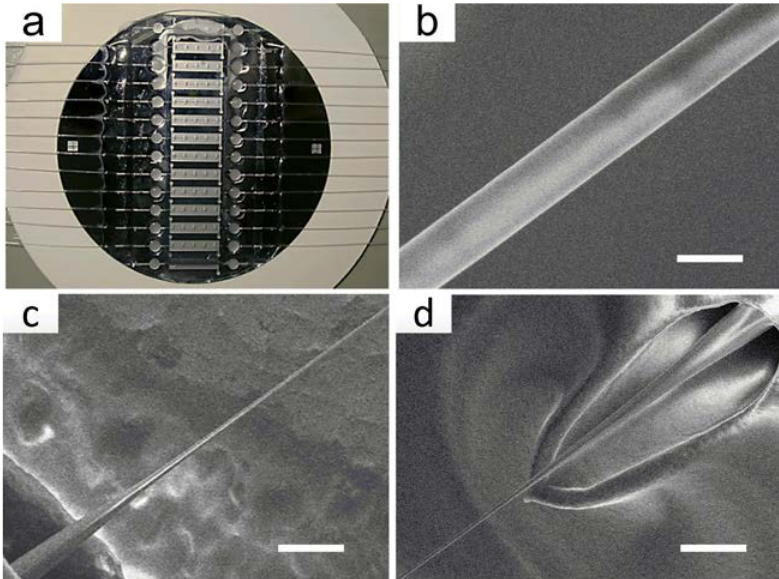
Figure 4. Fabrication of the OMNF. ( a ) OMNF sensor arrays; ( b ) An scanning electron microscope image showing the uniform waist of the fabricated OMNF (scale bar: 1 µm); ( c , d ) Down-taper and up-taper of the OMNF (scale bar: 10 µm).